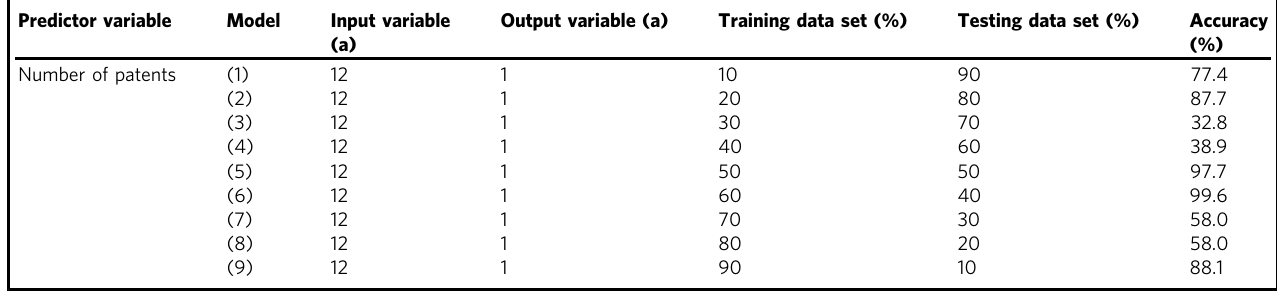
Table 5 Prediction accuracy of the arti fi cial neural network model on the in fl uencing factors of construction enterprises ’ adoption of green development behaviors.